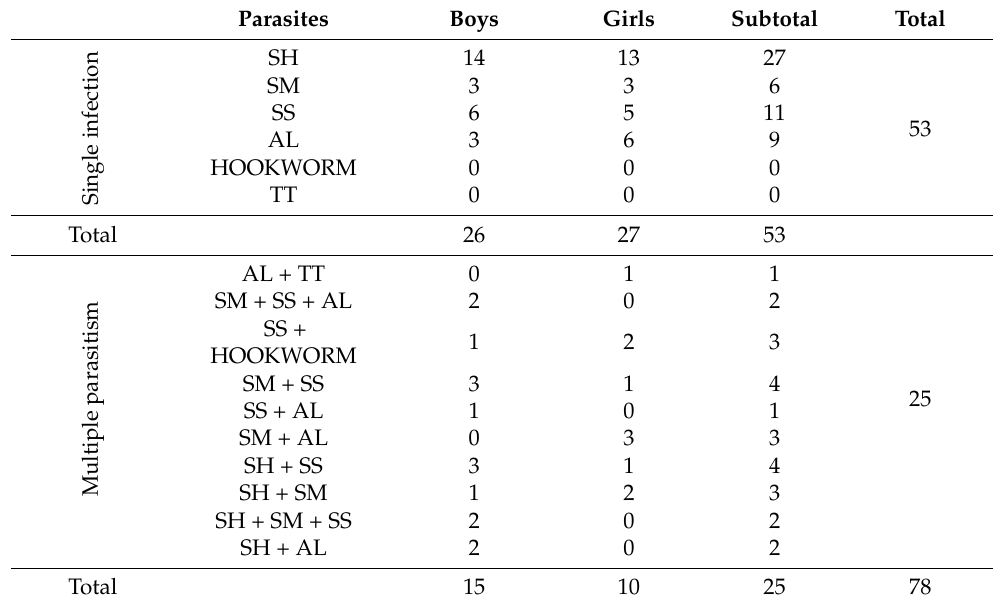
Table 1. Distribution of urogenital and intestinal schistosomiasis and intestinal helminths in the population studied and the most frequent combination of